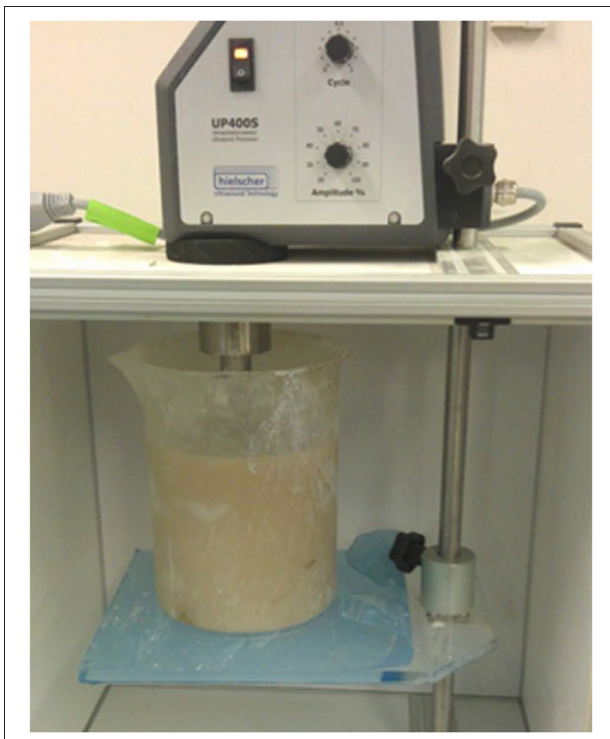
FIGURE 3 | Dispersion of nano alumina in water contining superplasticizer solution in ultrasonication